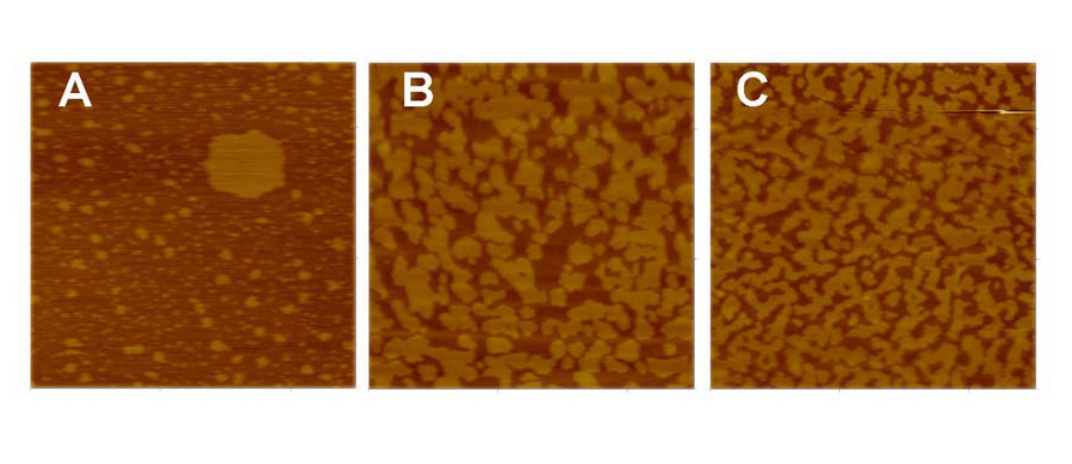
FIGURE 5. Microdomains in SM/POPC monolayers (30 mN/m). SM enriched ordered microdomains in 1:3 (A) and 3:1 (B) SM/POPC monolayers. (C) 3 :1 SM/POPC + 20 mol% cholesterol. Scan size 2.5 × 2.5